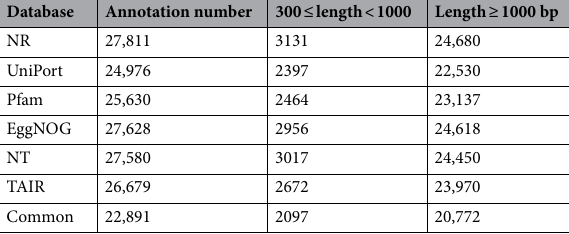
Table 3. Annotation of isoforms on the basis of public databases.